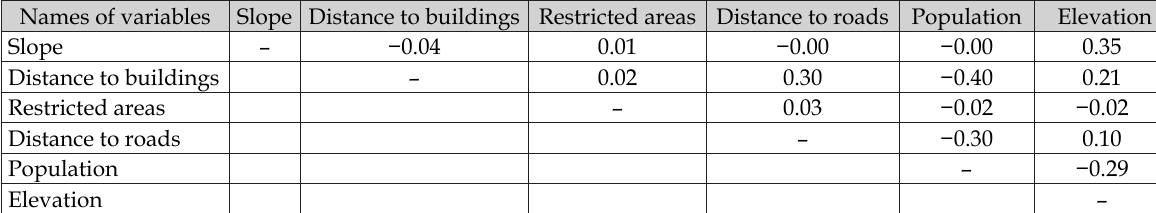
Table 4. Correlation values between explanatory variables.